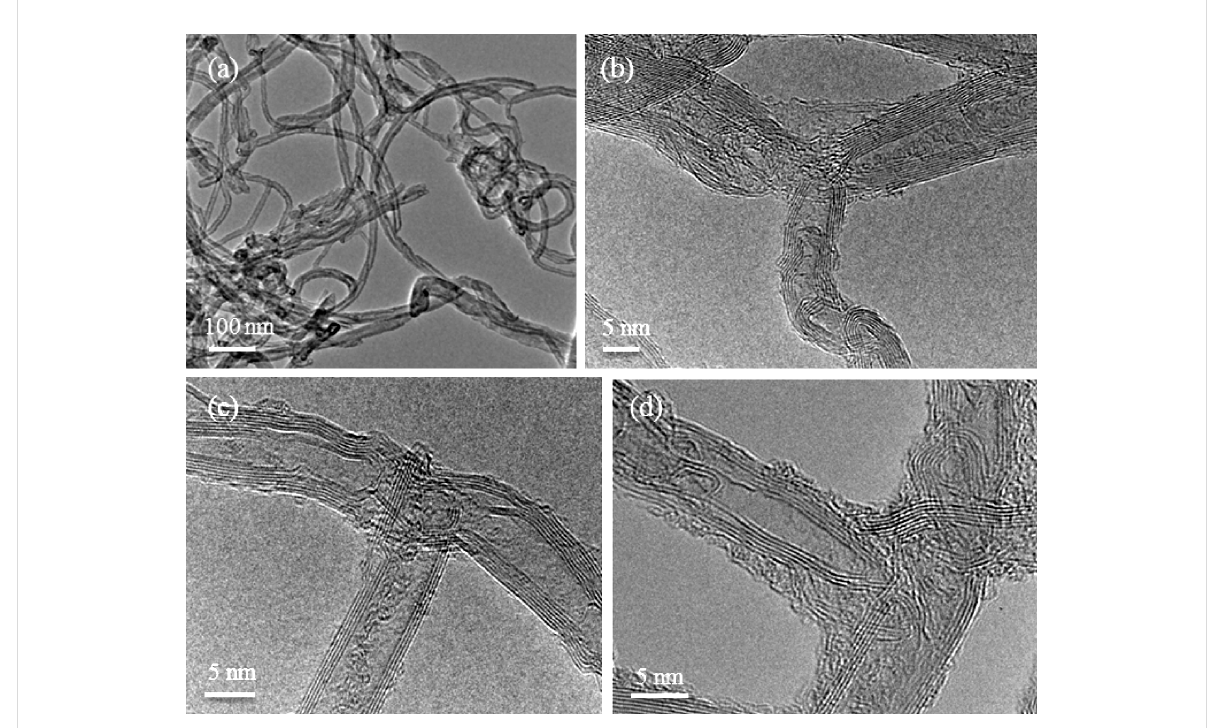
Figure 3: a) HRTEM overview of branched-MWCNTs and b) HRTEM detail of Y-pattern b-MWCNTs; c, d) HRTEM detail of T-pattern b-MWCNTs.